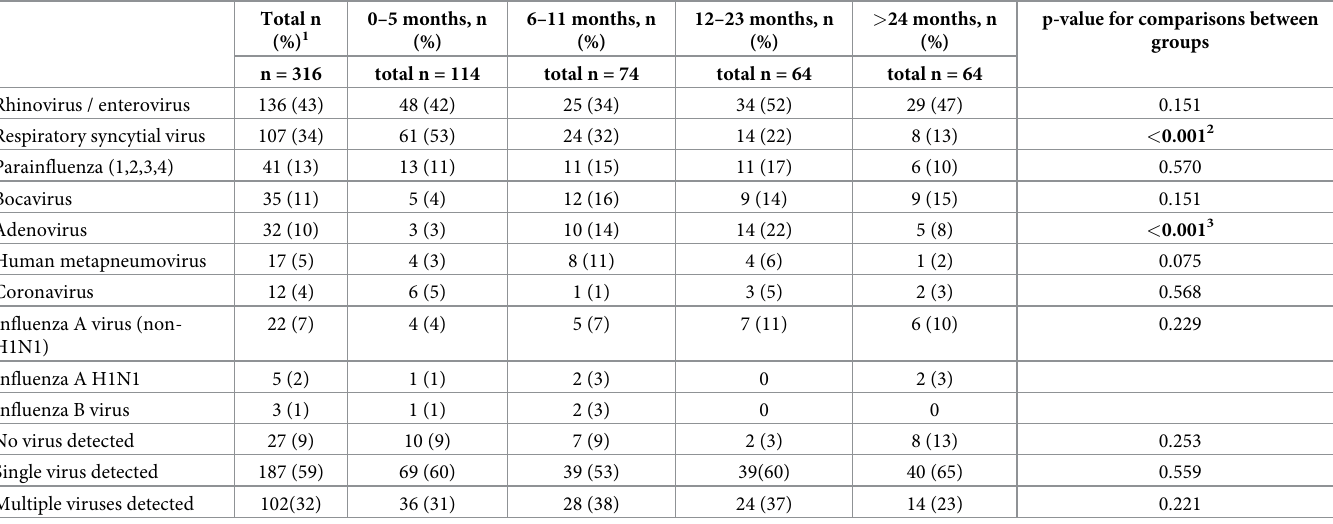
Table 2. Total (n = 409) and age-stratified number of viruses in Surinamese children hospitalized with acute respiratory infection (n =